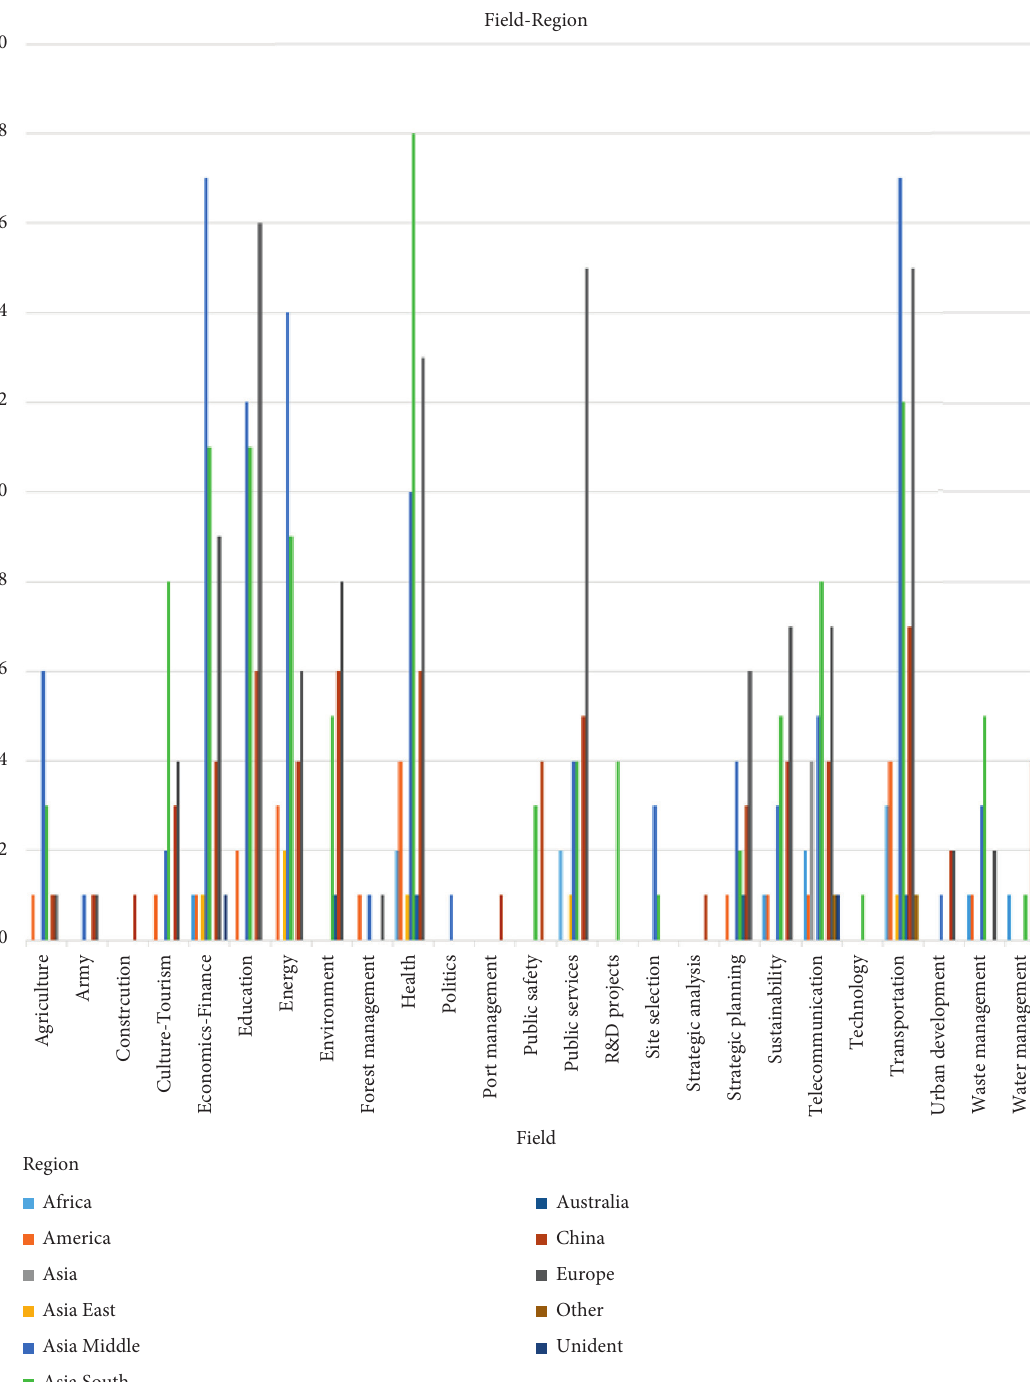
Figure 12: Crosstabulation by research field and